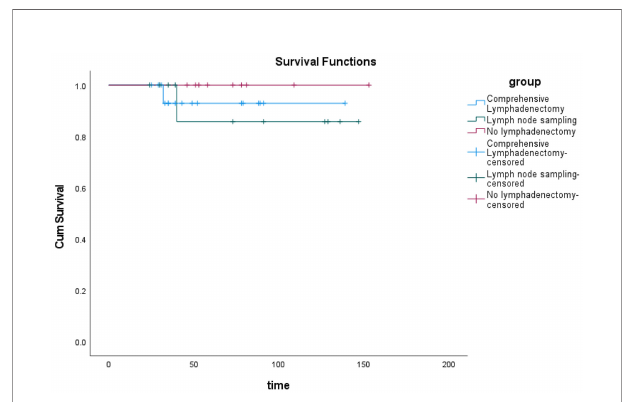
FIGURE 1 | The overall survival of patients with eEOC who underwent comprehensive lymphadenectomy or lymph node sampling or did not